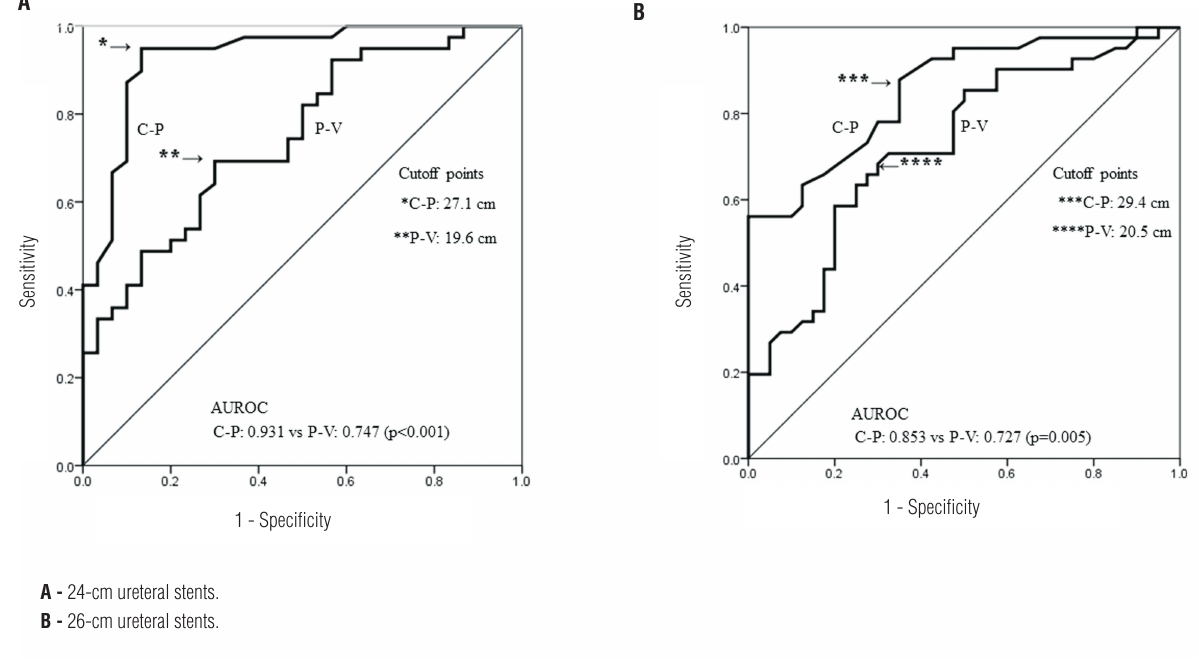
Figure 4 (A, B) - Receiver operating characteristic curves for success of ureteral stenting of KUB and CT, and area under the receiver operating characteristic curve